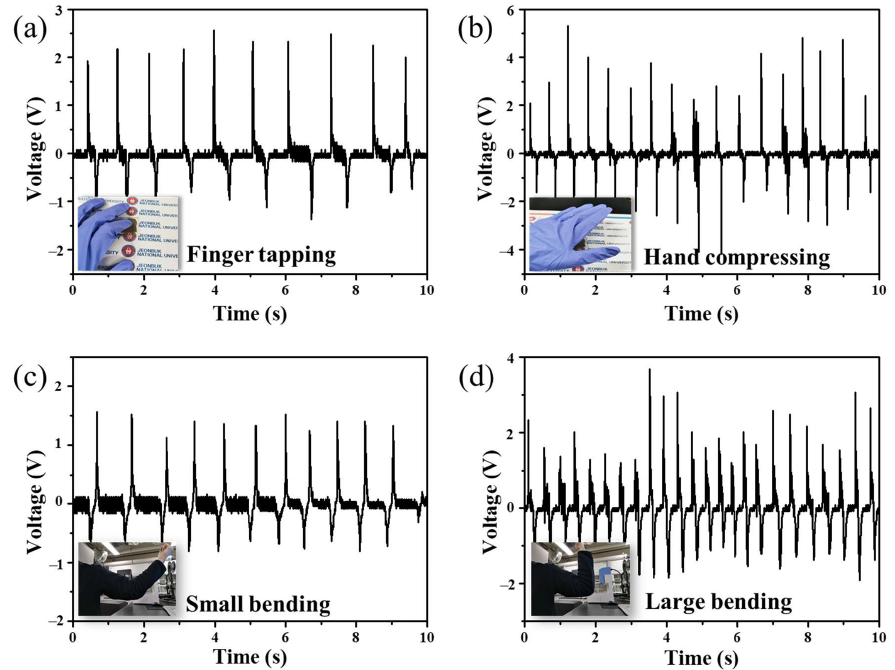
Figure 8. Output voltages generated by the screen-printed TOS-BTO/PVDF PENGs at ( a ) finger tapping and ( b ) hand compressing positions. Output voltages generated by the screen-printed TOS-BTO/PVDF PENGs at ( c ) small and ( d ) large bending positions.